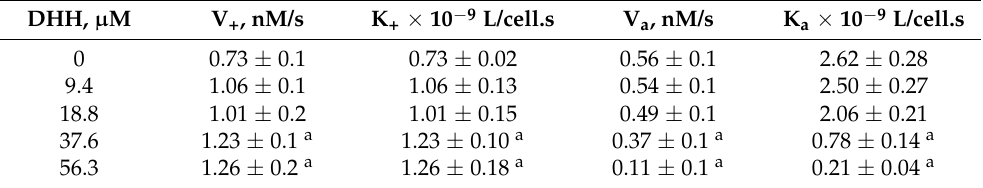
Figure 8. Ability of DHH to inhibit the P-gp mediated efflux of the drug in K562/ADR cells. Exper- iments were conducted in 1 cm quartz cuvettes under vigorous stirring. Cells were incubated with 5 mM glucose, 1 µM of pirarubicin (THP), 0.01% Triton X-100, and various concentrations of DHH: ( A ) Overall nuclear concentration in the steady state (C n ) of THP after the K562/ADR cells were incubated with various concentration of DHH; ( B ) the intracellular concentration of pirarubicin (C i ) after the K562/ADR cells were incubated with various concentrations of DHH; ( C ) the k ia /k 0a ratio, representing a decrease in the P-gp mediated THP efflux. The data are shown as mean ± SD from 3 independent experiments performed in triplicate. The significance of mean differences was assessed using one-way ANOVA. * p < 0.05 as compared with a condition without DHH. Table 1. Kinetics of the pirarubicin uptake into K562/ADR after treatment with various concentrations of